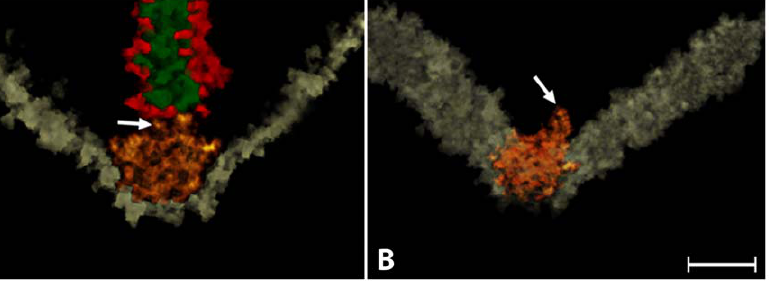
Figure 3. The arciform density. Panel A shows that the arciform density (orange) is shaped as a pentamer instead of an amorphous particle. Four sides of the pentagon are attached to the plasma membrane and the upper side to the plate of the ribbon via two short filaments (arrow). A central core (green) and surface densities for the attachment of the tethered vesicular pool (red) comprised the ribbon. The yellow line is the perpendicular view of the plane of the plasma membrane. Panel B shows a top view of the same arciform density. To gain a better view of this region, the ribbon was removed by density segmentation (see Materials and Methods). This top view reinforces the idea that the arciform density is a cage that links the ribbon to the plasma membrane (yellow). Bar: 50 nm.